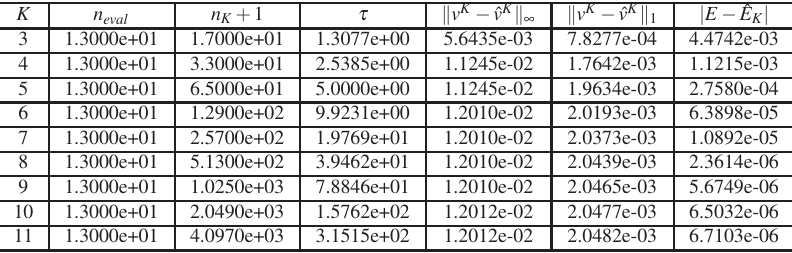
Table 2 Parameters as specified in Table 1 for f 1 , ε = ε k = 10 − 1 and the polygonal rule.